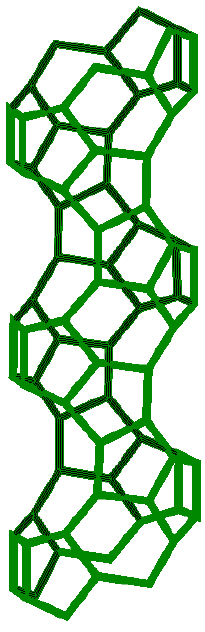
Figure 15. 12-ring channel of the zeolite type BETA [compiled by the authors].